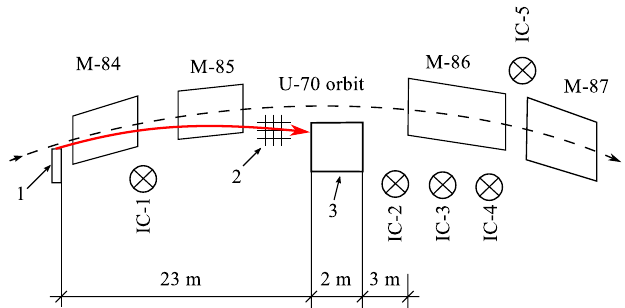
FIG. 3. The main elements of the experimental equipment: 1—station with a crystal, 2—profilometer, 3—absorber, IC— ionization chambers, M—magnetic blocks of the accelerator.